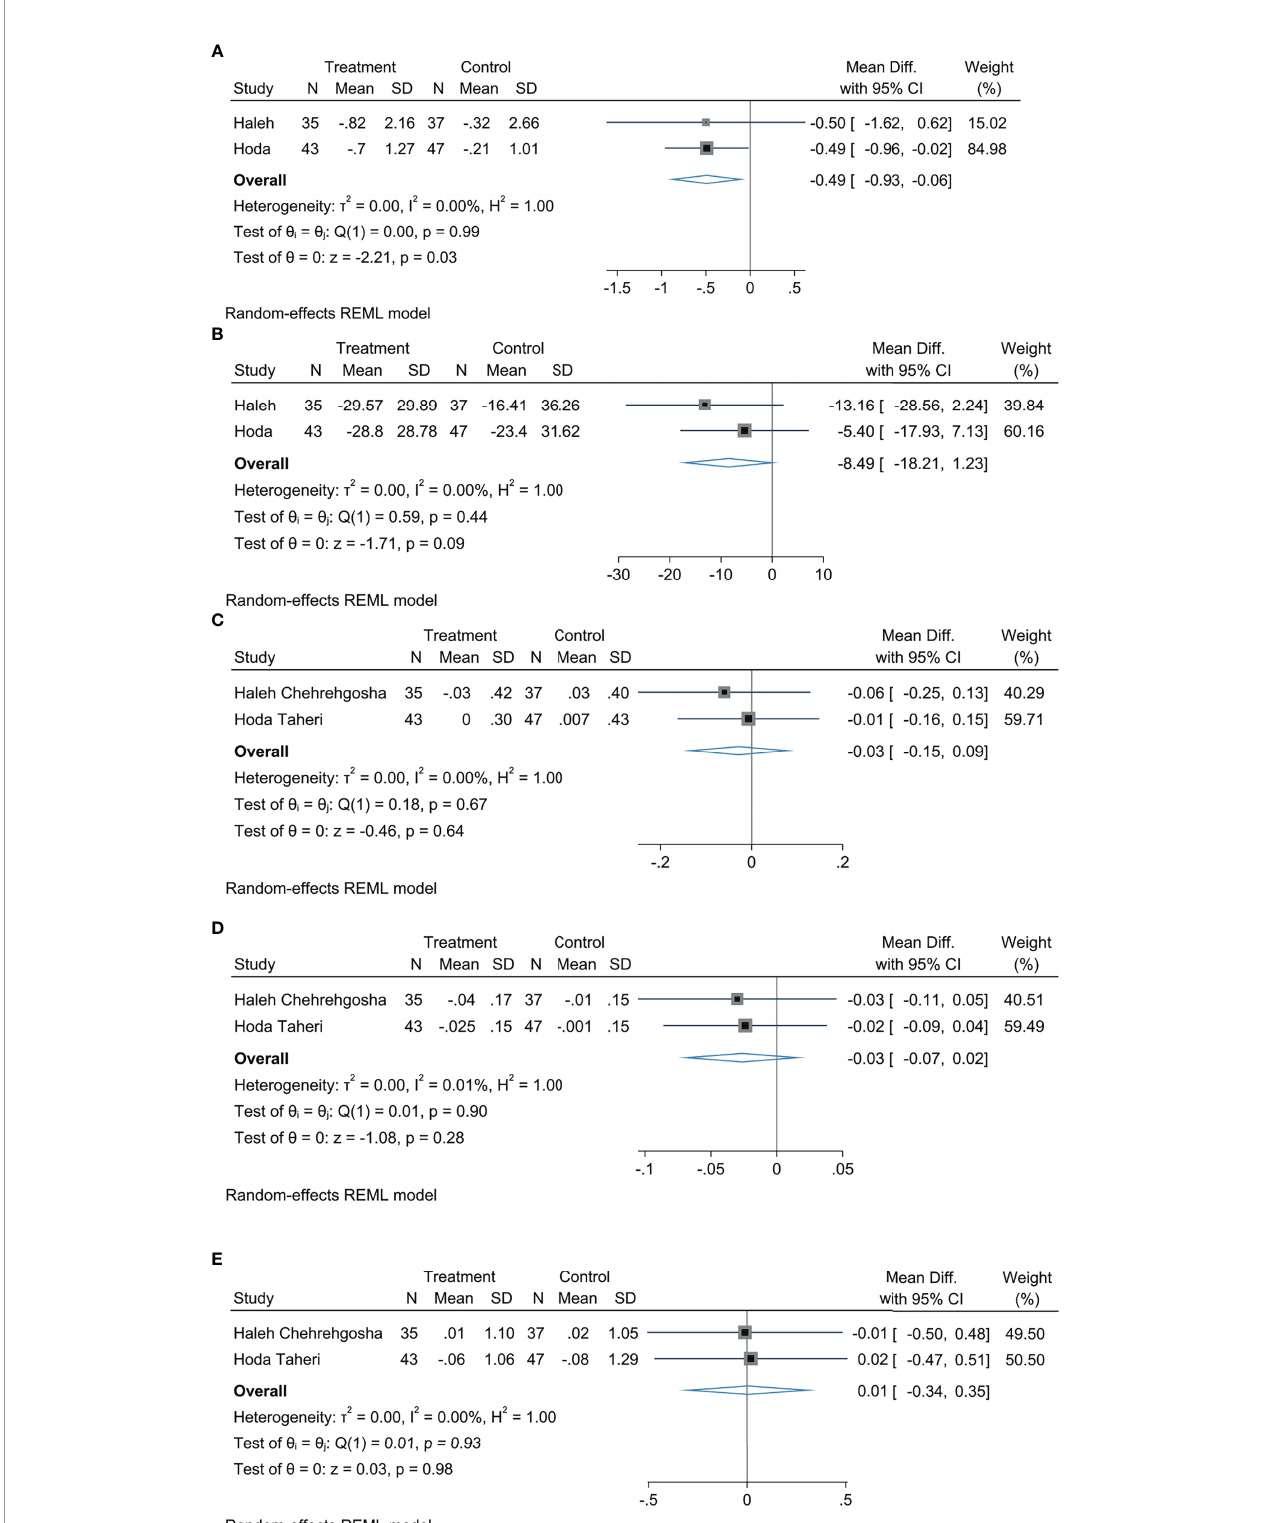
FIGURE 6 | The effect of empagli fl ozin on LSM (A) ; the effect of empagli fl ozin on CAP (B) ; the effect of empagli fl ozin on FIB-4 (C) ; the effect of empagli fl ozin on APRI (D) ; the effect of empagli fl ozin on fasting plasma glucose NFS (E)